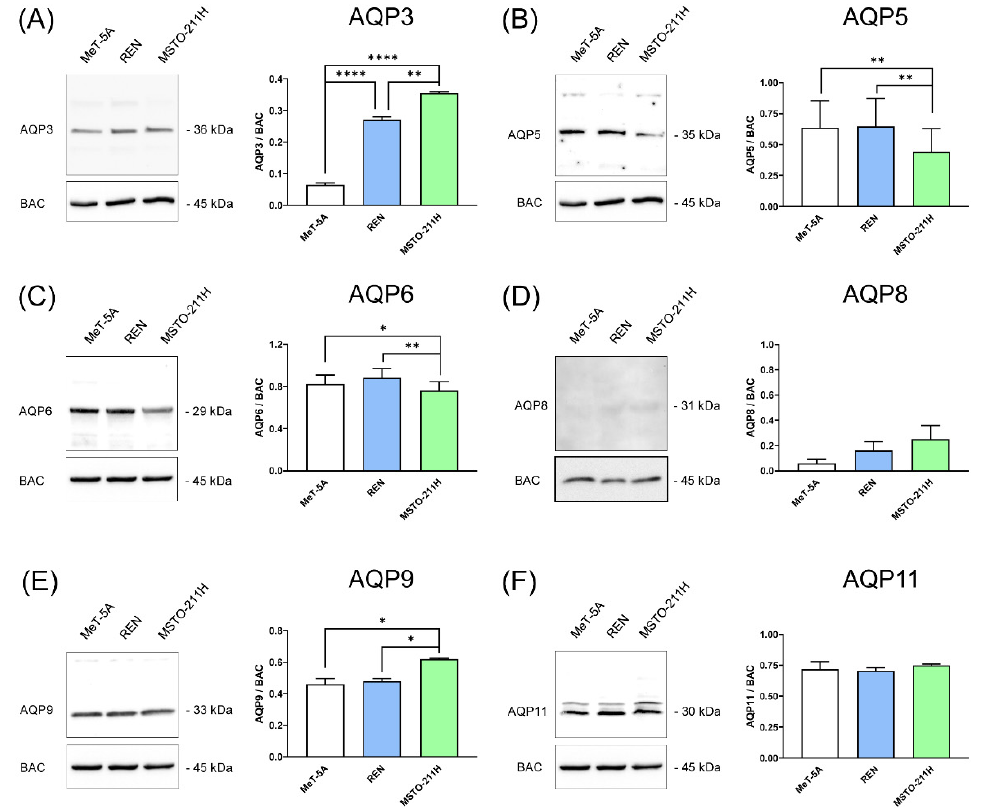
Figure 2. Immunoblotting and densitometric analysis of AQP3 ( A ), AQP5 ( B ), AQP6 ( C ), AQP8 ( D ), AQP9 ( E ), and AQP11 ( F ) in mesothelial (MeT-5A, in white), epithelioid, and biphasic MPM cell lines (REN and MSTO-211H, in blue and green, respectively). ( Left panels ) Representative blots of three different experiments are shown. Lanes were loaded with 30 µg of proteins, probed with affinity-purified antibodies, and processed as described in Materials and Methods. The same blots were stripped and re-probed with anti- β -actin (BAC) antibody, as housekeeping. Major bands of the expected molecular weights are shown. ( Right panels ) Densitometry of AQP protein levels in the three cell lines. Each bar represents the mean ± SEM of the normalized values of AQP protein expression. *, p < 0.05; **, p < 0.01; ****, p < 0.0001. (ANOVA followed by Newman–Keuls’s Q test.)